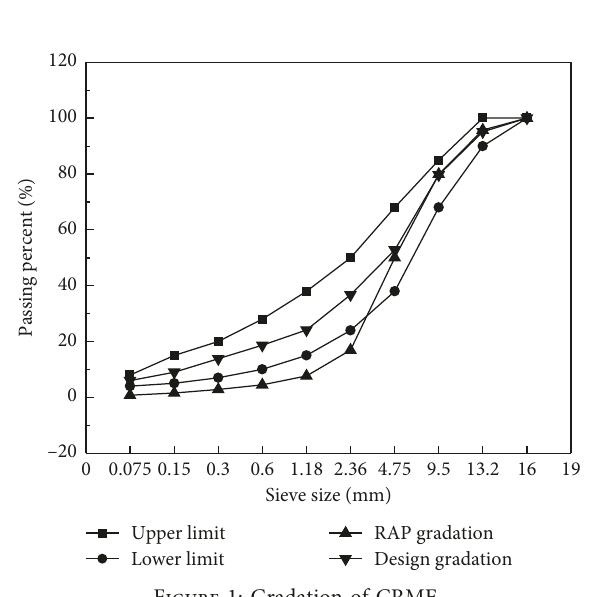
Figure 1: Gradation of CRME.